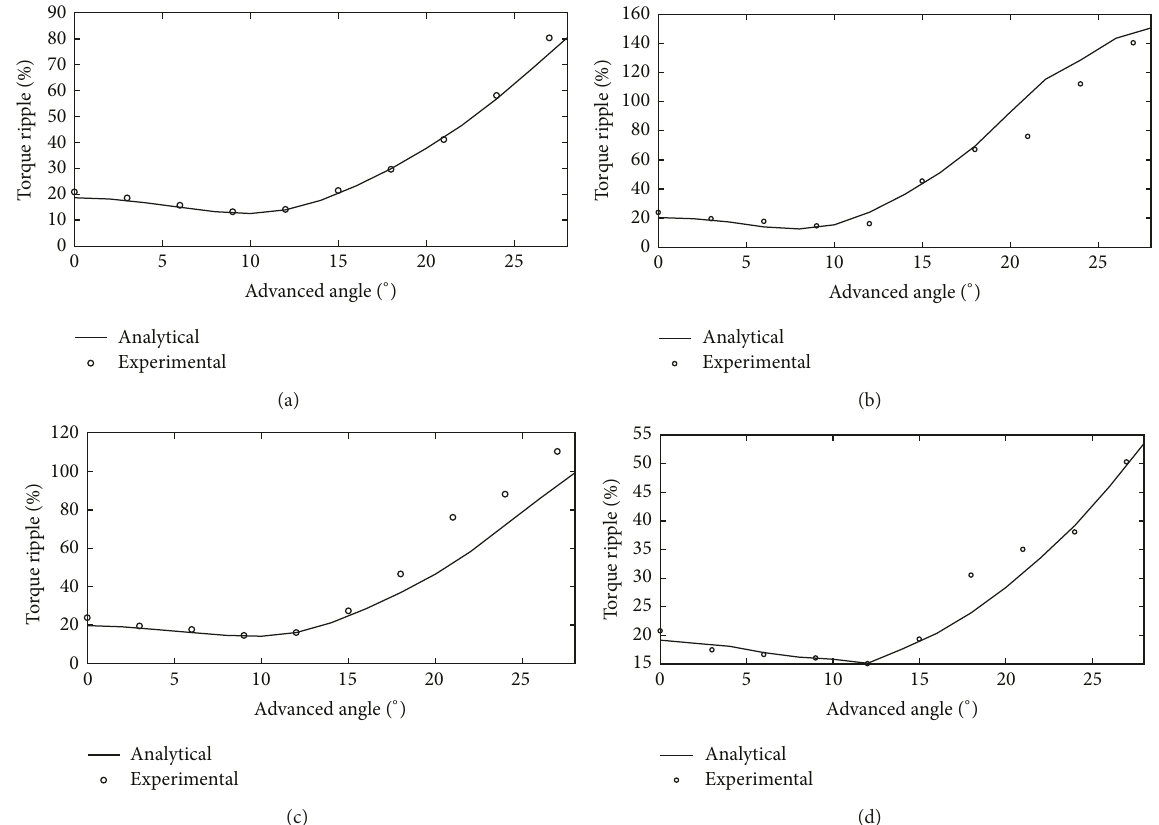
Figure 10: The waveforms of torque ripple with the variation of advanced angle from the experimental and analytical methods: (a) 1000rpm and 0.8Nm condition; (b) 1500 rpm and 0.4 Nm condition; (c) 1500 rpm and 0.8 Nm condition; (d) 1500 rpm and 1.5Nm